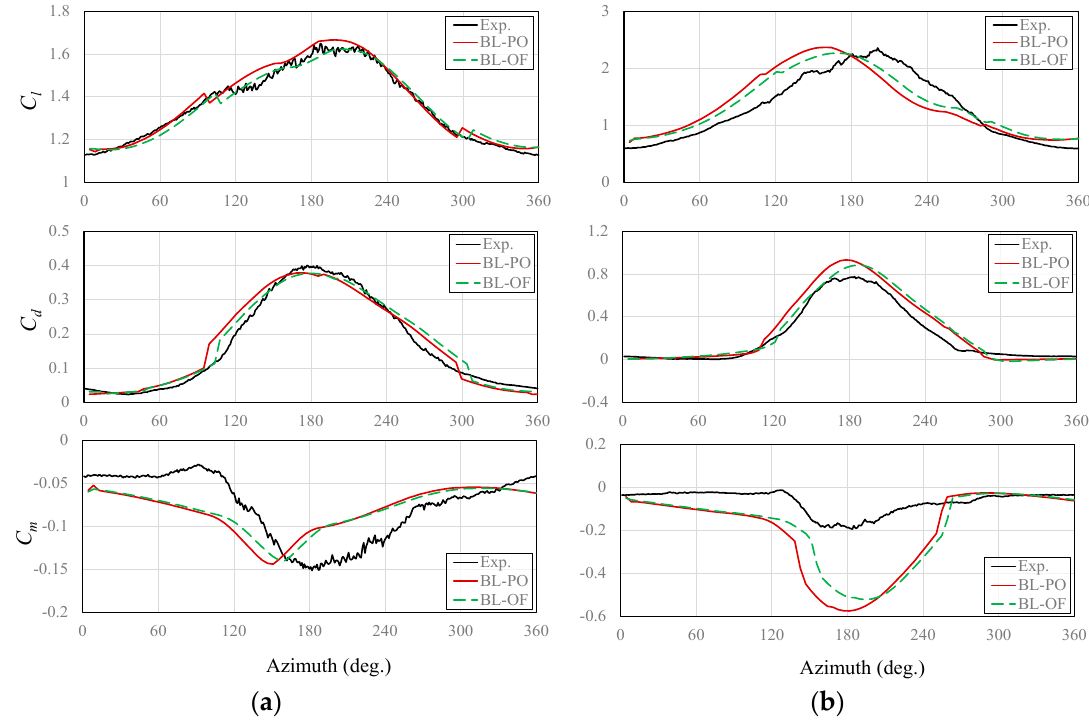
Figure 16. Effect of the yaw angle on the aerodynamic coefficients. The wind speed is 10 m/s, and the radial location is 30% span. ( a ) 10° yaw angle, and ( b ) 30° yaw angle.